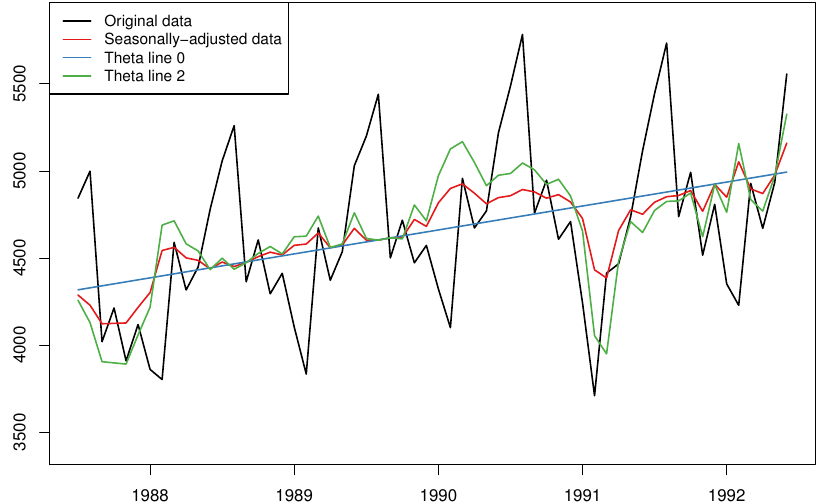
Figure 1. An illustrative example of producing theta lines for the theta method. The original data (black line) are de-seasonalised (red line). Then, a linear regression on trend produces the theta line with θ = 0 (blue line). The theta line with θ = 2 (green line) has double the curvatures of the seasonally adjusted